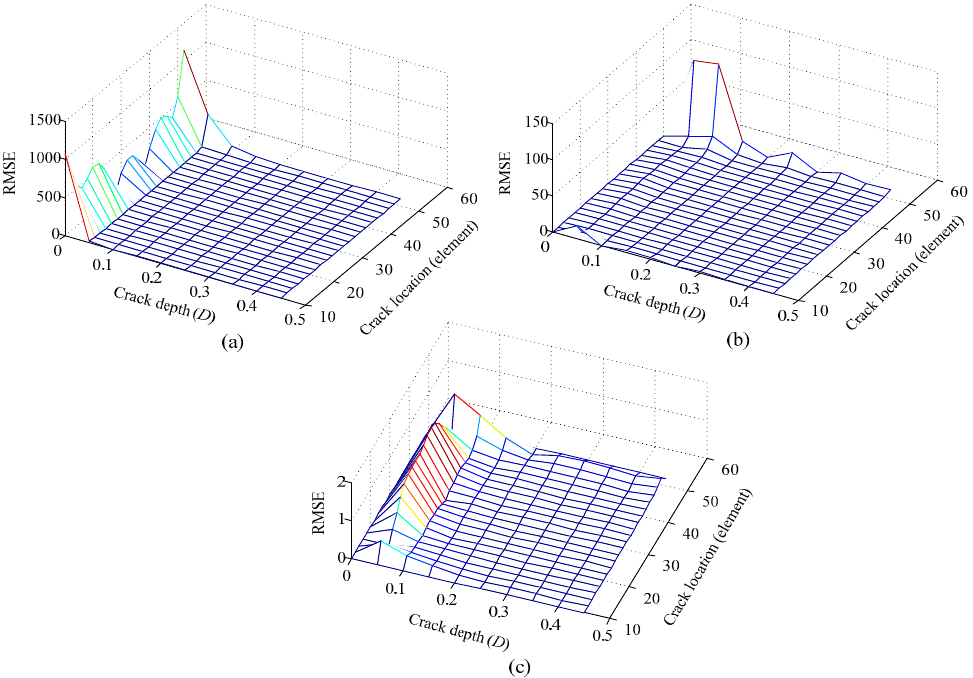
Figure 8. Distribution of RMSE by the established Kriging surrogate model using various sample sets ( a ) using initial samples; ( b ) after adding the samples near boundary the first time; ( c ) after adding the samples near boundary the second time.